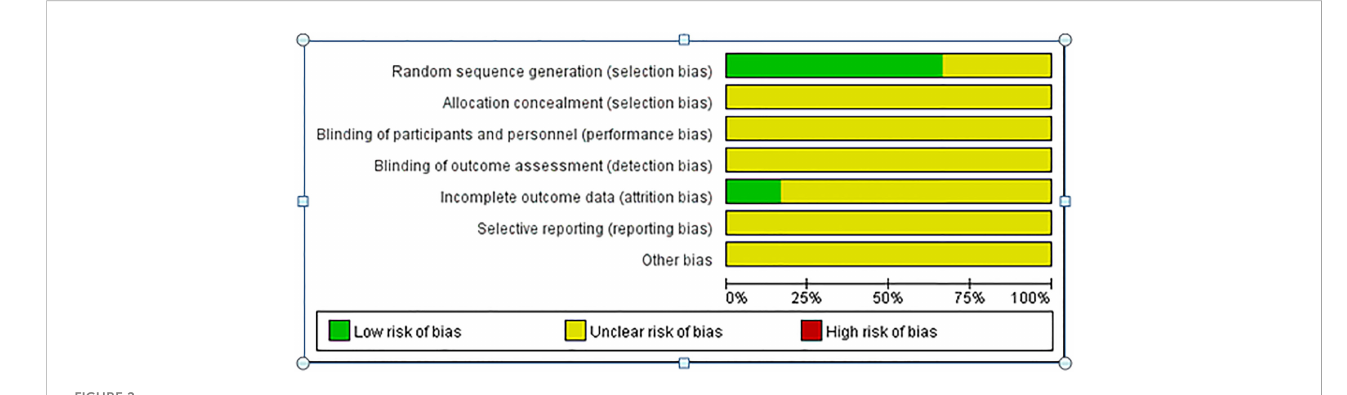
FIGURE 2 Quality assessment of the enrolled